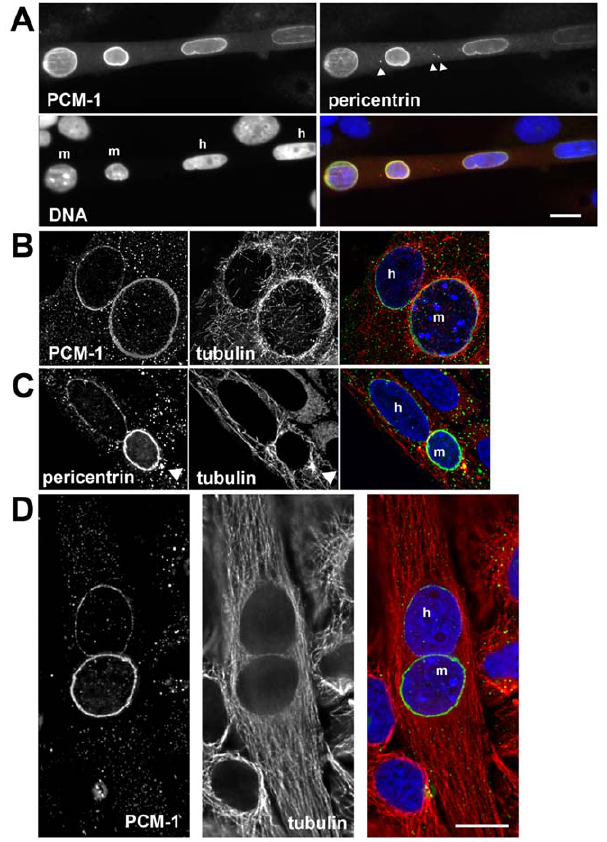
Figure 5. Microtubule nucleation from non-myoblast nuclei after fusion into heterokaryons with muscle cells. (A) Immuno- fluorescence of a heterokaryon of fused U2OS and H-2K b -tsA58 cells, containing two mouse nuclei (m) and two human nuclei (h), as identified by chromatin morphology. The centrosome proteins PCM-1 and pericentrin are stained with antibodies, displayed in the merged image in green and red, respectively. Centrosomal foci of pericentrin are visible (arrowheads), in addition to perinuclear pericentrin staining. DNA is marked with DAPI (blue). (B, C) Microtubule re-growth is shown in heterokaryons at 48 hours after fusion, containing one human (h) and one mouse nucleus (m). Microtubules were re-grown for 20 seconds after cold-induced depolymerization. Immunofluorescence of PCM-1 (green), and tubulin (red) is shown. DNA (blue) is stained with DAPI. The arrowhead in (C) indicates the position of a centrosomal pericentrin focus, nucleating microtubules. (D) Immunofluorescence of a heterokaryon after full microtubule polymerization, stained as indicated in (B, C). Bars in (A), (D), 10 m m.